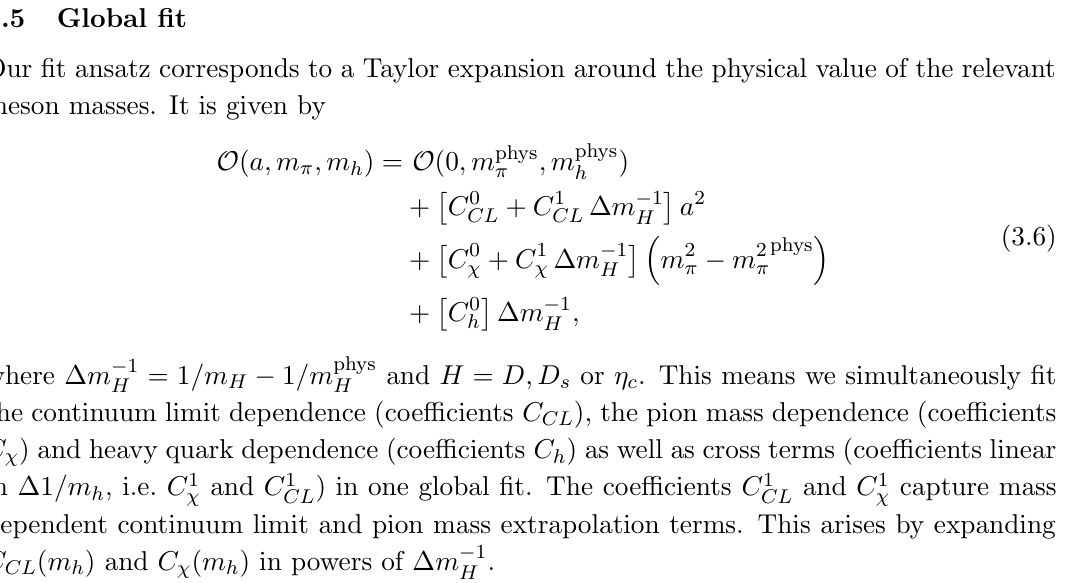
Figure 7 . The behaviour of (cid:8) D (left) and (cid:8) D the various ensembles. The black vertical line corresponds to the physical value as stated in the PDG